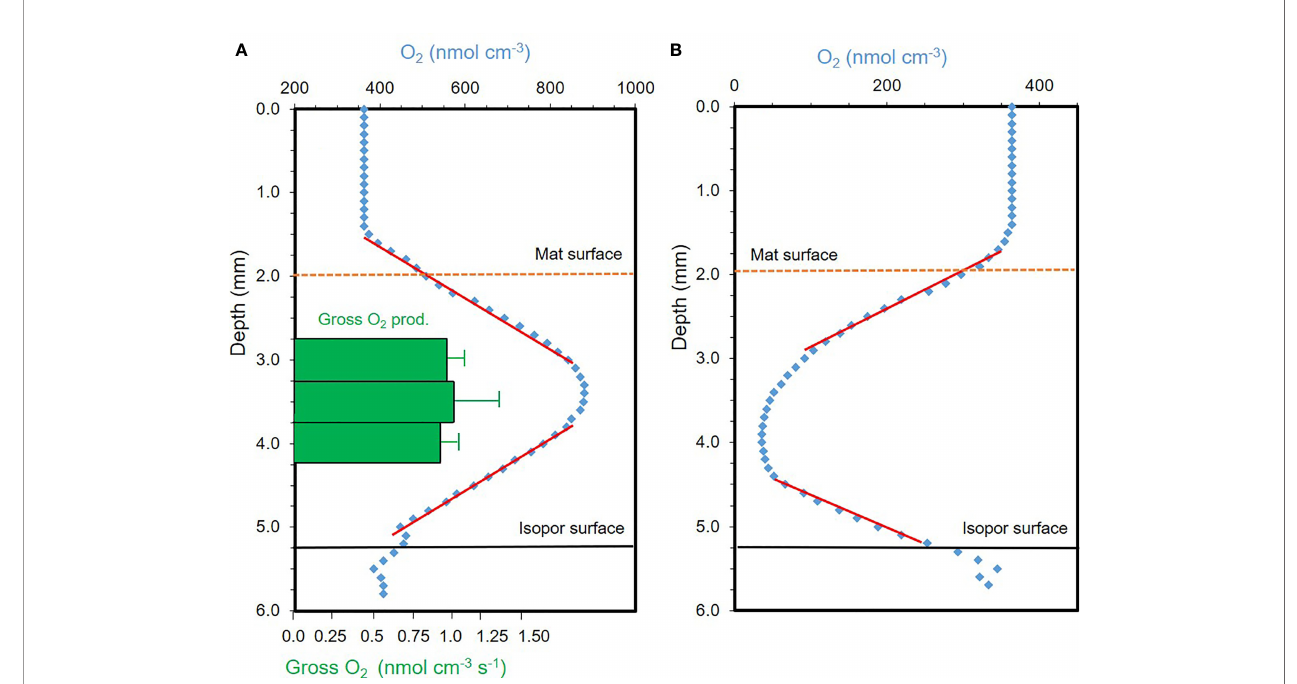
FIGURE 2 | Steady state oxygen concentration pro fi les through melt pond algal mats (blue dots) collected from Arctic sea ice melt ponds in (A) light (400 µmol photons m – 2 s – 1 ), and (B) darkness, respectively. Net O 2 production in the light, and dark O 2 consumption was calculated from the derived slope coef fi cients (red lines), respectively. Green bars in (A) represent the depth-resolved gross oxygen production derived independently from the net production, by the light-dark method (see M&M). The oxygen concentration pro fi les demonstrated a pronounced oxygen consumption in the dark that was surpassed by the oxygen production in light, driven by the exceeding gross